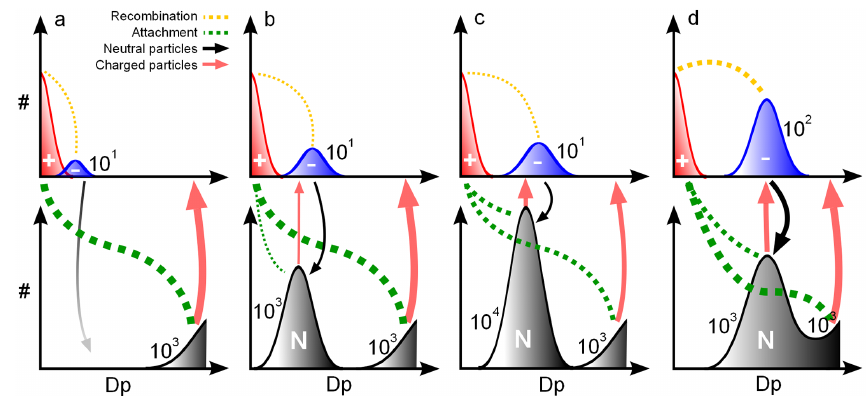
Figure 9. Conceptual model of the influence of cluster ion recombination and attachment at different stages of particle nucleation and growth (a–d) . Permanently available positive cluster ions are denoted in red, the negative growing mode in blue and neutral particle modes in black. The black and red arrows denote the generation of neutral and charged particles, respectively. The size of the arrows and dashed lines denotes the prevailing mechanism. Numerals indicate the orders of magnitude of the number concentrations of the respective